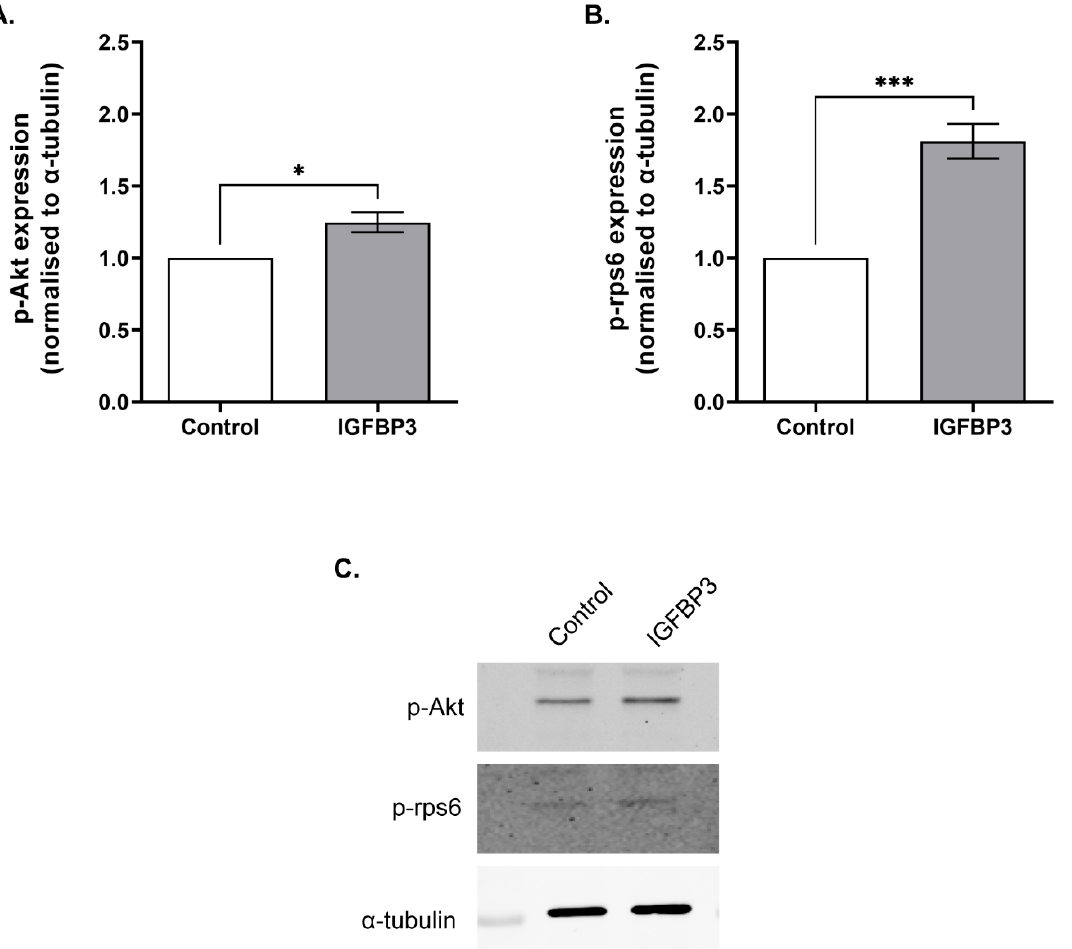
Figure 5. IGFBP3 increases phosphorylation of rpS6 and Akt. Effect of 100 ng/mL IGFBP3 on ( A ) phospho-Akt levels and ( B ) phospho-rps6 in 4–8 cell embryos, detected by Western blotting. Data are average phosphorylated protein band intensities (±SEM, n = 3) normalised to α -tubulin and are expressed relative to the control. ( C ) Representative Western blot of 4–8 cell embryos exposed to 100 ng/mL IGFBP3 for 10 min. Western blots were probed for anti-p-Akt (upper panel) anti-p-rps6 (middle panel) and anti- α -tubulin (lower panel). Statistical analysis was performed using an unpaired t -test. * = p < 0.05 *** = p < 0.001.